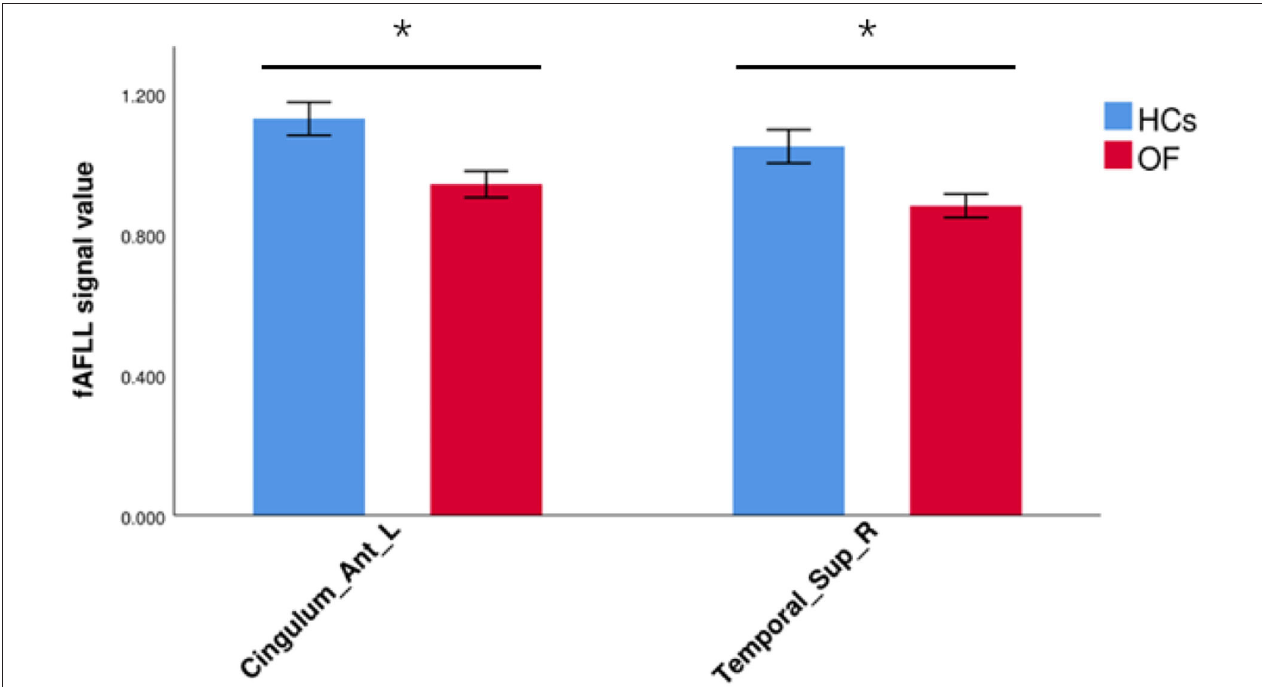
FIGURE 2 | The average fALFF values in OF and HC groups. Cingulum_Ant_L, left anterior cingulate gyrus; Temporal_Sup_R, right superior temporal gyrus; fALFF, fractional amplitude of low-frequency fluctuation; OF, orbital fractures; HC, healthy control. “*” p < 0.05.